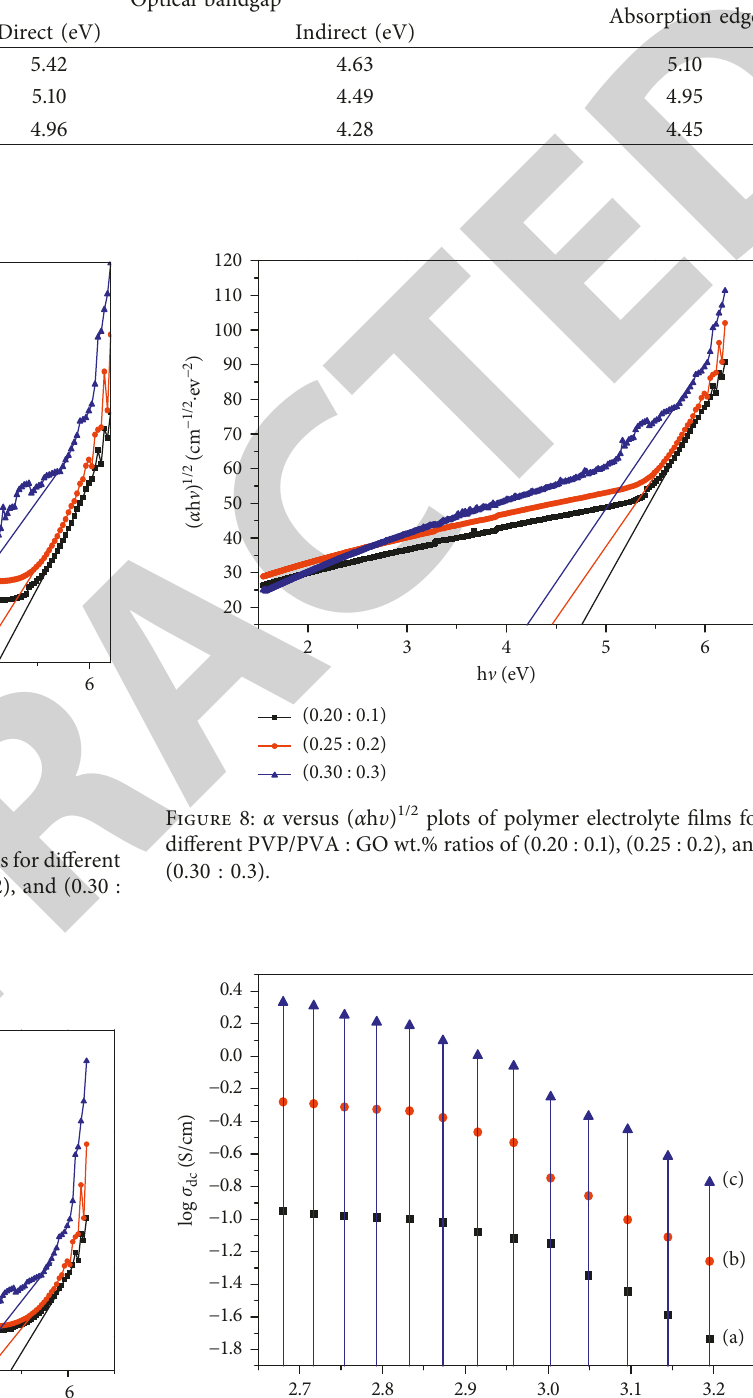
Absorption edge